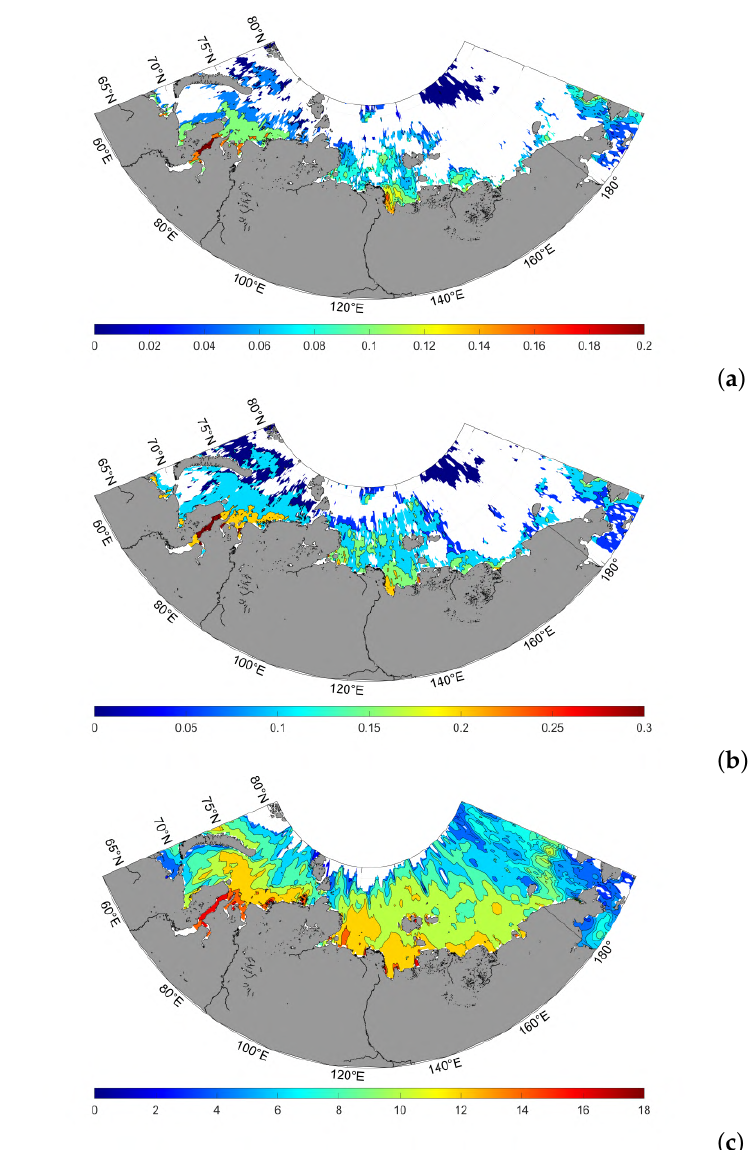
Figure 3. Linear trends of MHW characteristics in the Siberian Arctic seas: ( a ) mean intensity (in ◦ C), ( b ) maximum intensity (in ◦ C) and ( c ) total duration (in days) per year. White spaces denote areas lying beyond 95% confidence